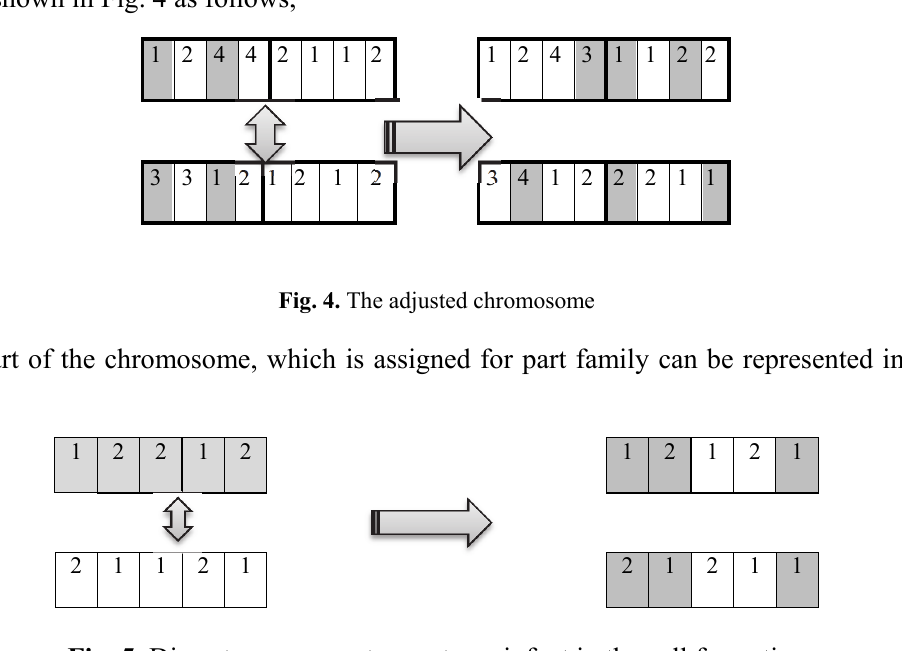
Fig. 5. Discrete crossover to create an infant in the cell formation